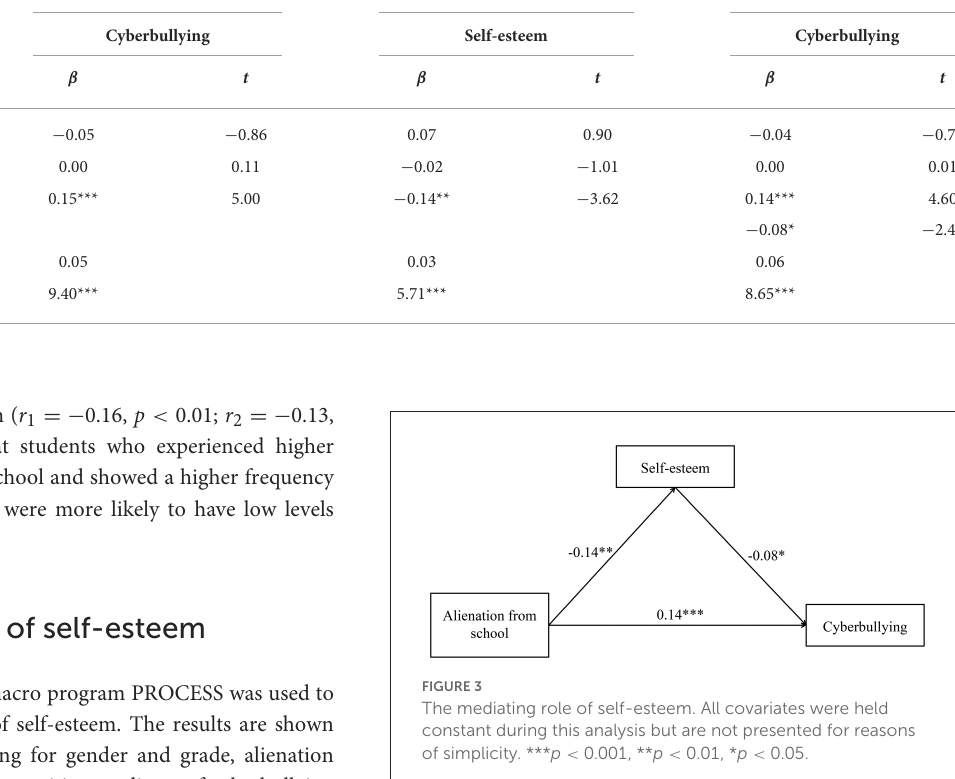
TABLE 2 The mediating model of alienation from school and cyberbullying. Variables